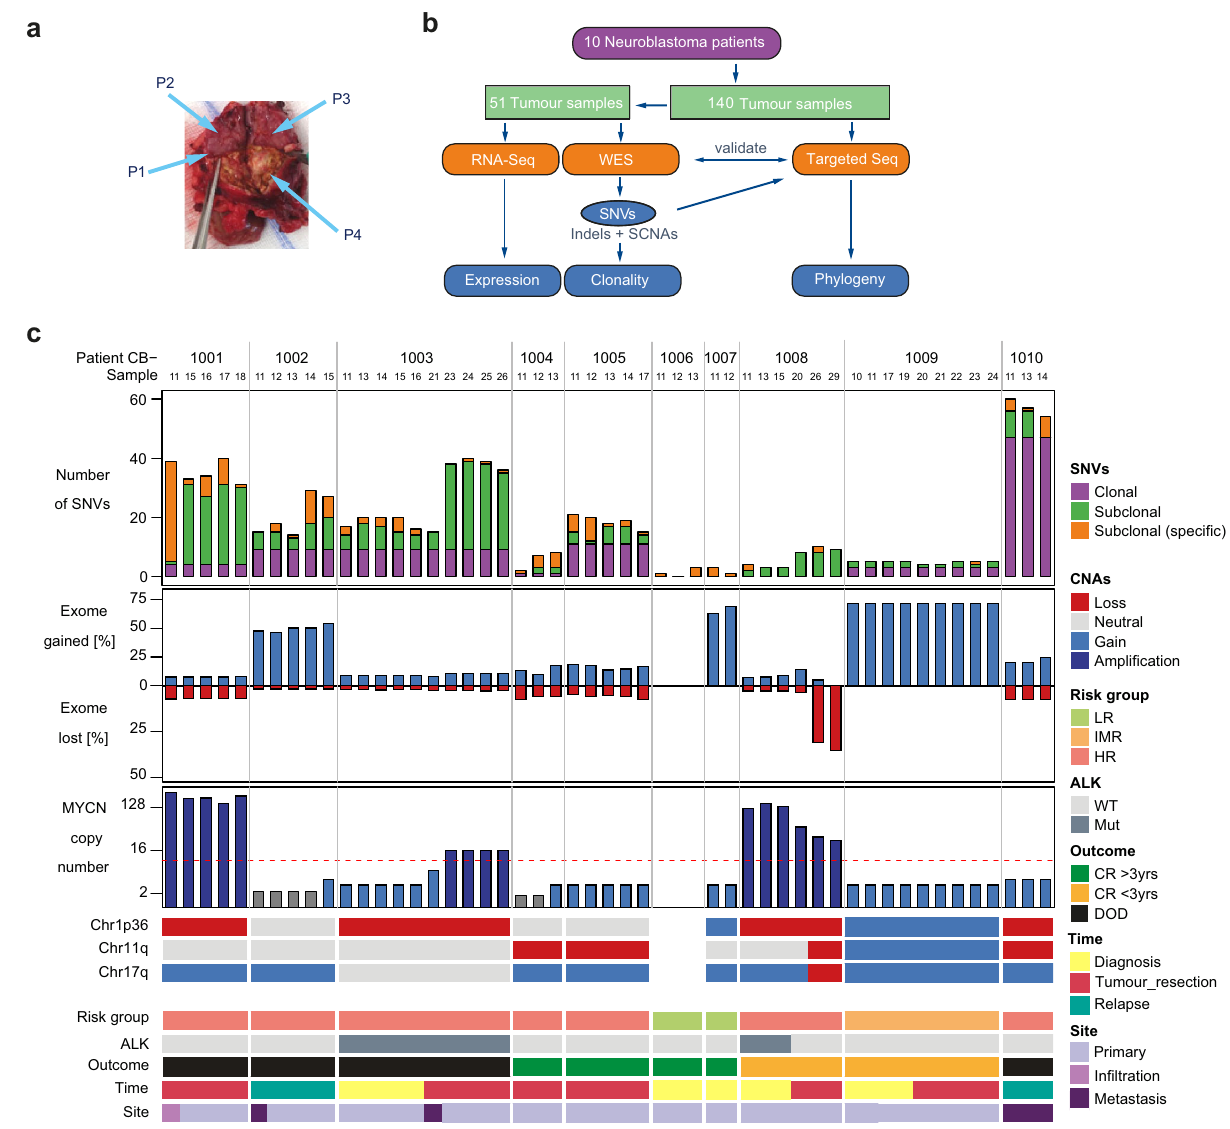
Fig. 1 Study design and overview of neuroblastoma intratumour heterogeneity determined in 10 patients from multi-region WES and targeted re- sequencing. a Representative picture of a neuroblastoma (arrows indicate spatially separated samples for analysis). b Study design and sample work fl ow. c Oncoplot outlining patient/sample characteristics and WES results from 51 neuroblastoma samples collected from 10 patients (CB1001 – CB1010). Columns correspond to individual samples. Gained regions are indicated in blue, lost regions are marked in red. Risk strati fi cation determined patient risk at diagnosis as high (HR), intermediate (IMR) and low (LR) according to current practice. Patient outcomes are indicated, including death of disease (DOD) and complete remission (CR), with CR being >3 years for this cohort. SNV, non-synonymous single-nucleotide variants; SCNA, somatic